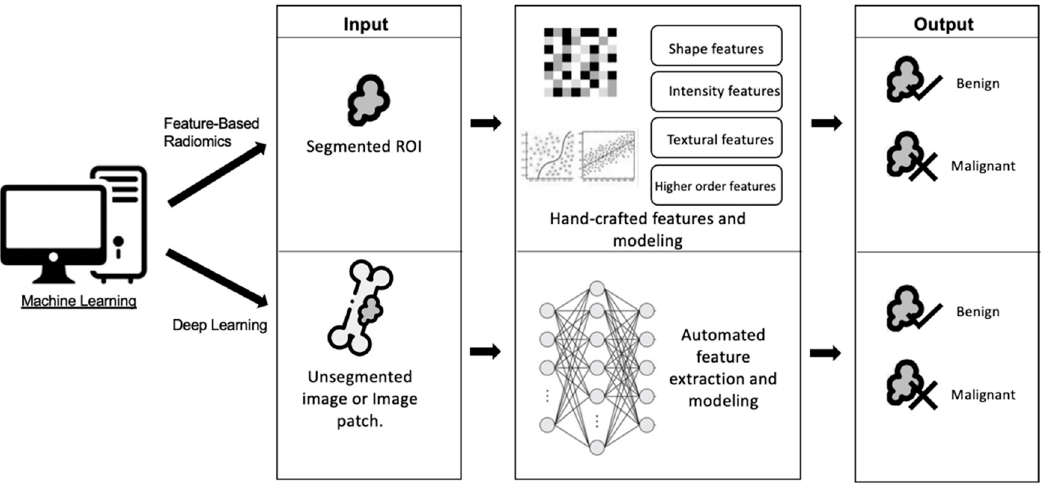
Figure 3. A diagram illustrating the difference between the two most popular techniques for machine learning; feature-based radiomics vs. deep learning for classifying lesions.